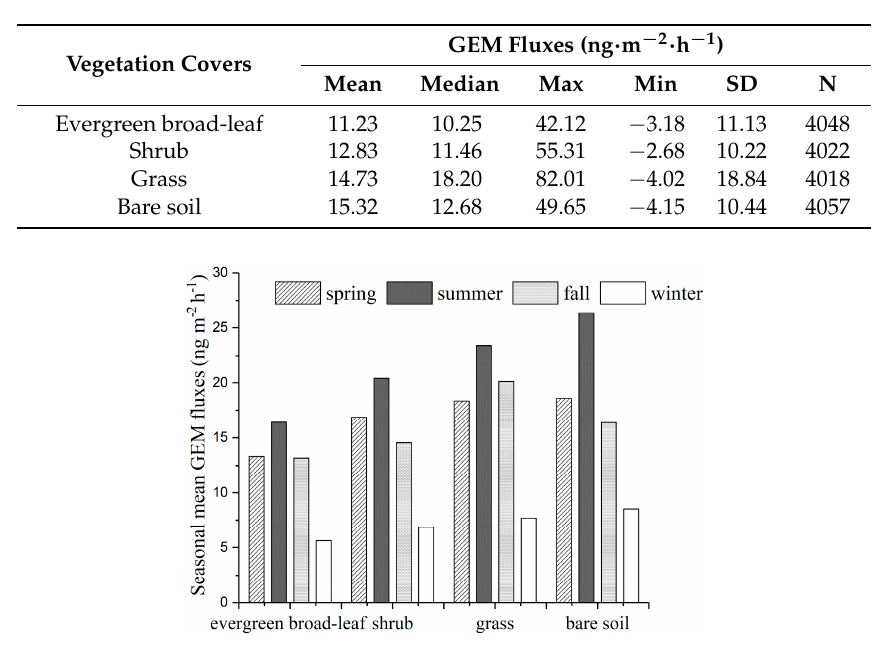
Table 1. Statistical analysis of the GEM (gaseous elementary mercury) fluxes at the soil–air interface under different vegetation covers for two years.